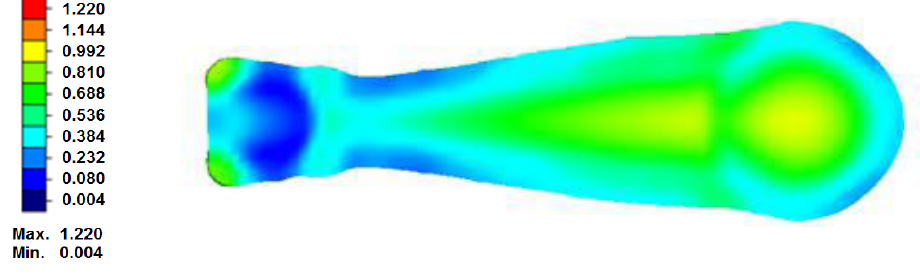
Figure 10. Connecting rod strain obtained by finite volume simulation [27].